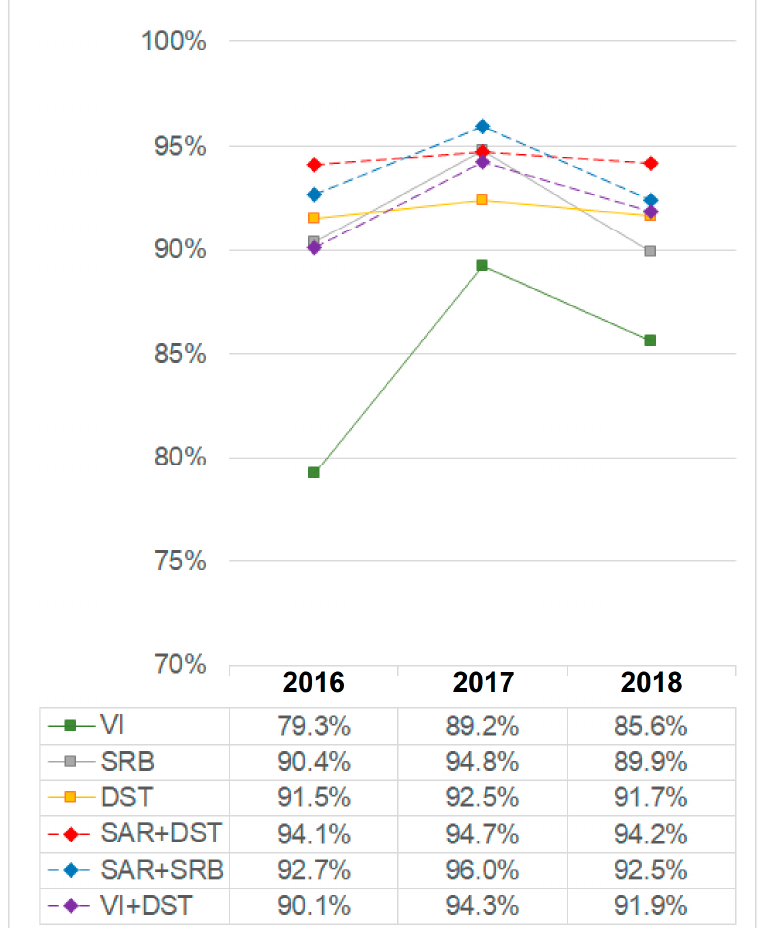
Figure 7. Annual differences in the mean accuracy value ((PA + UA)/2) for the palm plantation class across the three years analyzed. Values are presented for each one of the previously selected approaches. Full lines represent approaches using features from a single spectral region, while dashed lines represent data-fusion approaches.